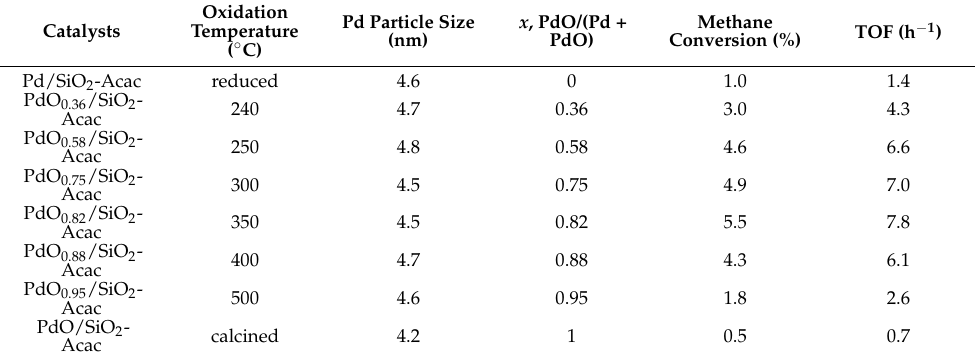
Table 2. PdO x /SiO 2 -Acac catalysts with different Pd oxidation states, related to oxidation tempera- ture and performance in lean methane